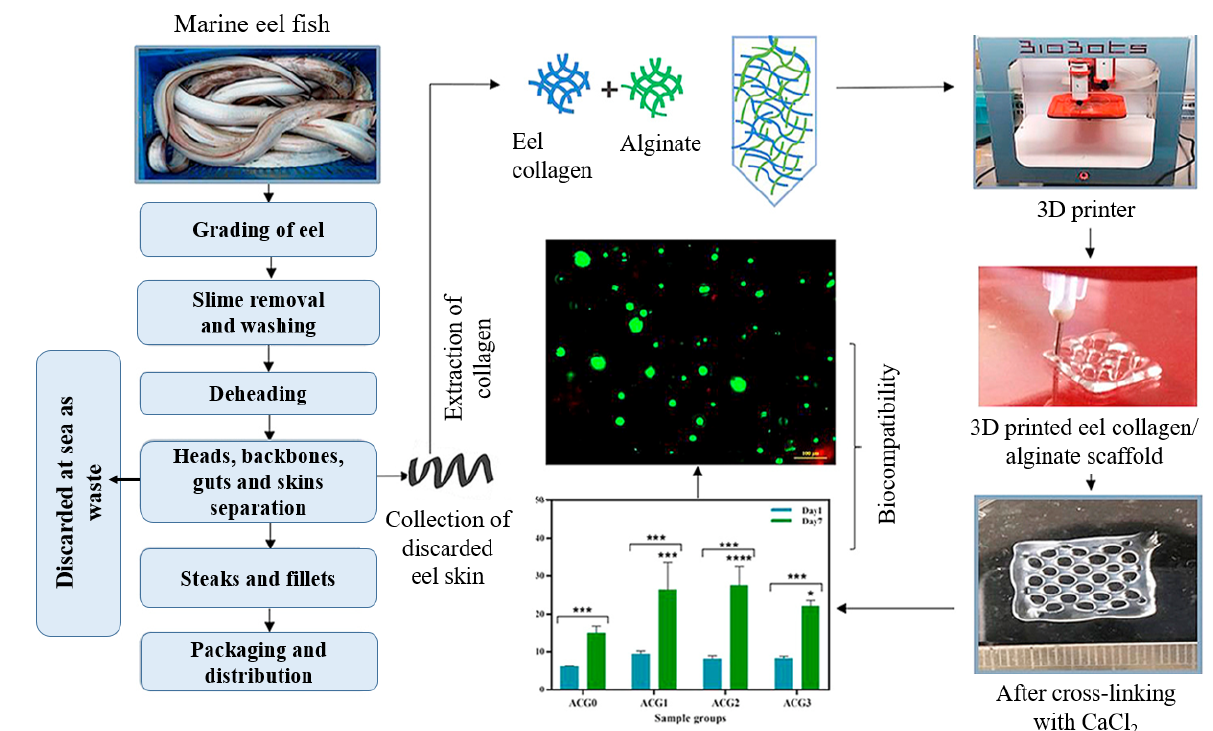
Figure 10. Biocompatible collagen-based scaffold from marine eel fish waste. *(p<0.05) indicates statistical significance between different groups and different time points. “Reprinted/adapted with permission from Ref. [28]. Copyright © 2019, Elsevier”